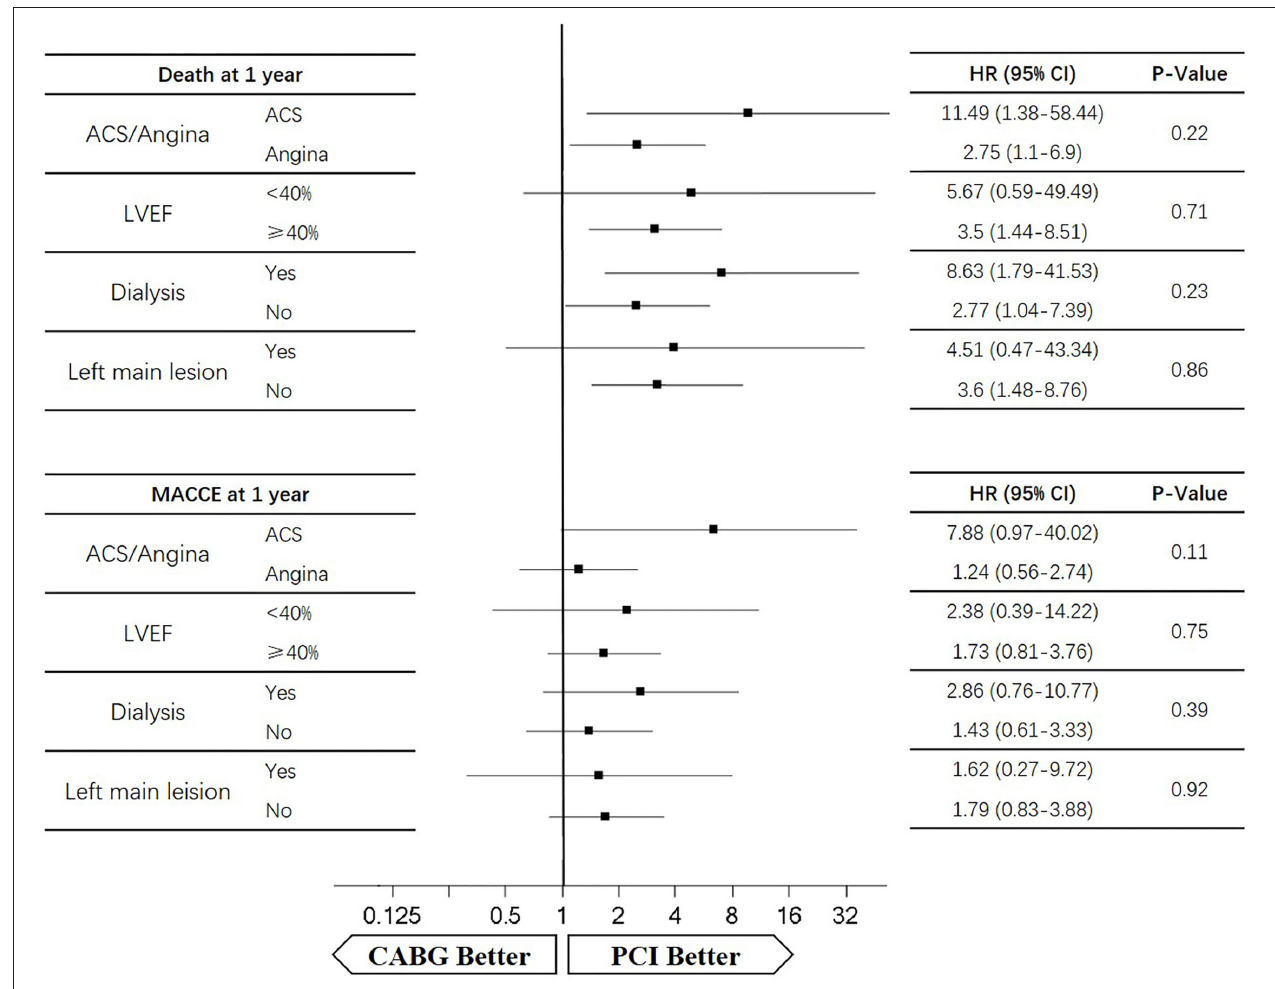
FIGURE 7 | The 5-year death and MACCEs for patients according to